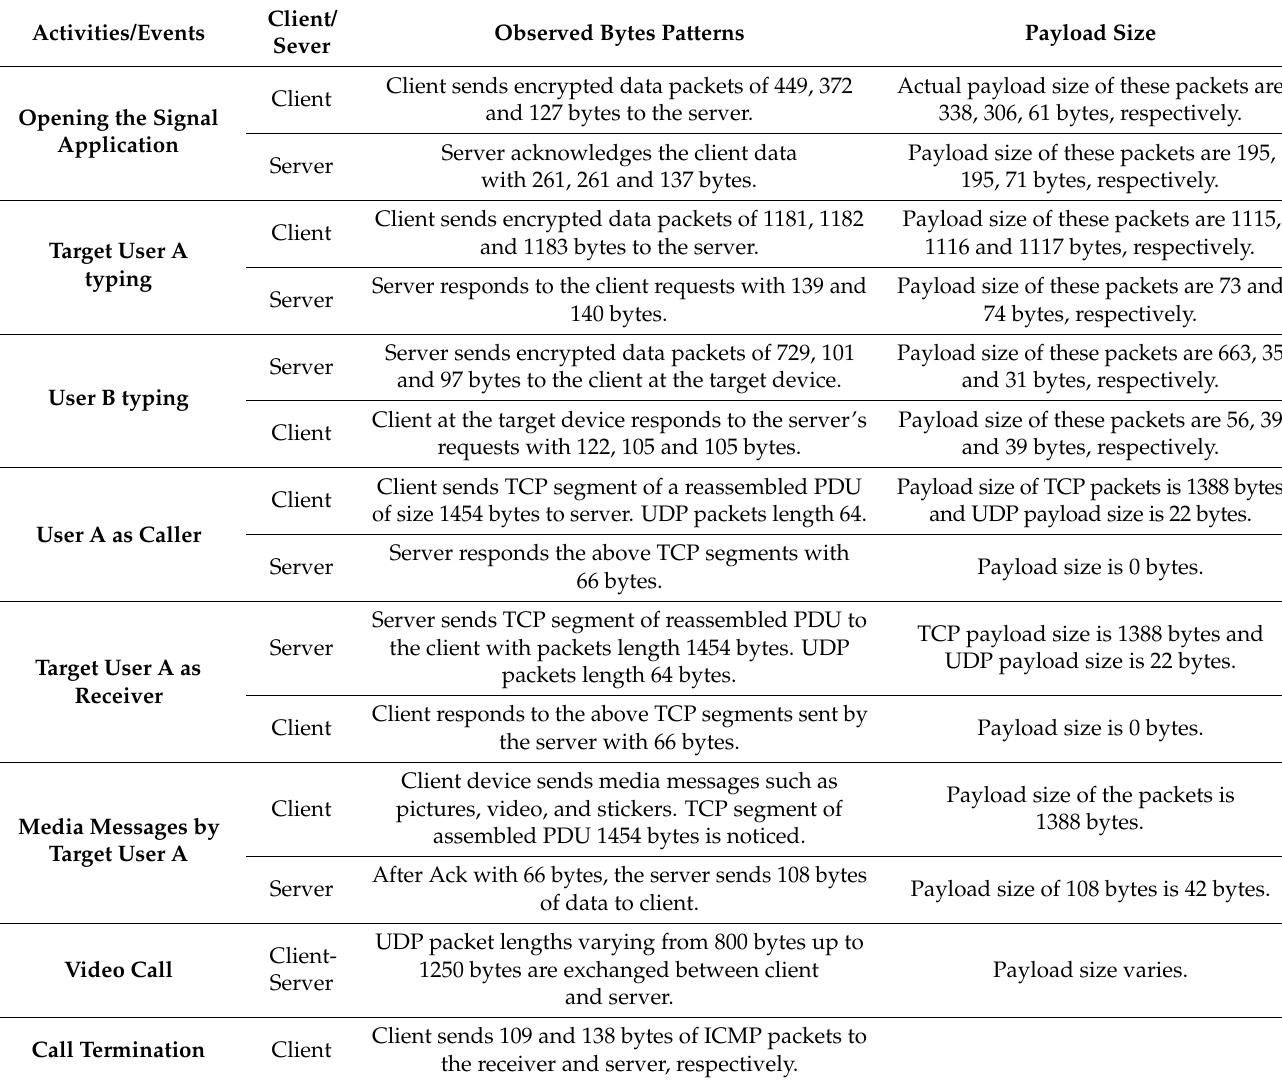
Table 4. Summary of observed traffic characteristics of Signal app on android